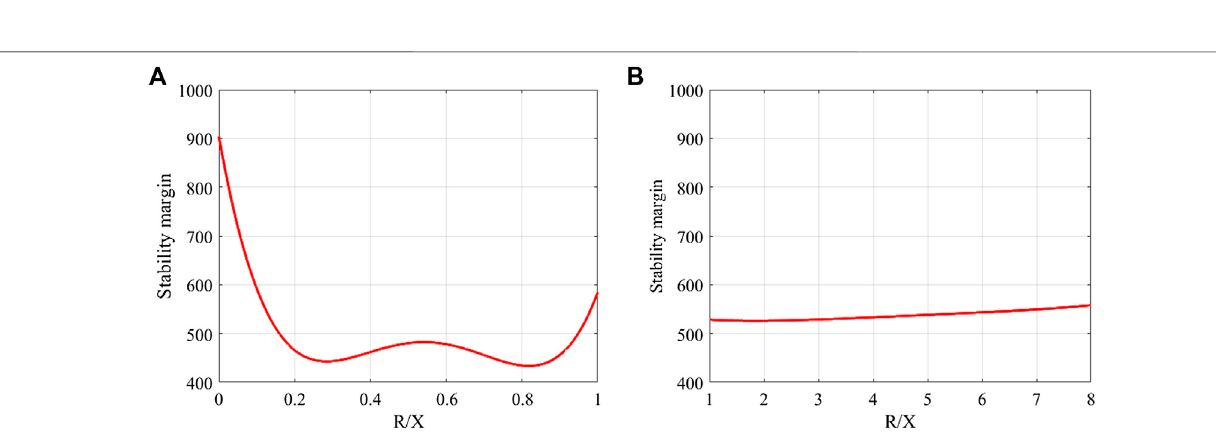
Frontiers in Energy Research |